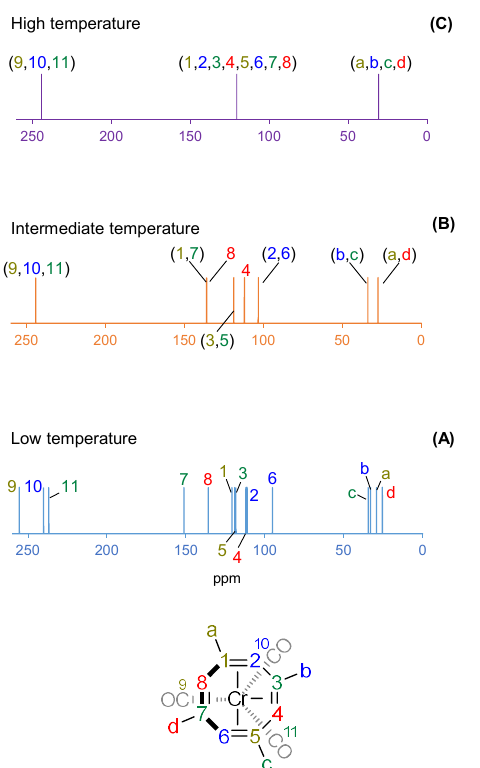
Figure 6. Simulated GIAO-PBE0/BS6//PBE0/BS1 13 C-NMR spectrum of (TMCOT)Cr(CO) 3 at low temperature ( A ), intermediate temperature ( B ), and high temperature ( C ). Chemical shifts are relative to TMS.